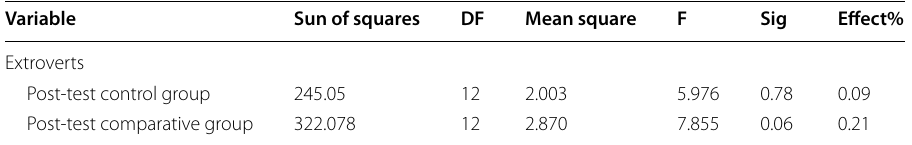
Table 6 ANCOVA on the Post-test scores of extrovert learners in the comparative group and the control group